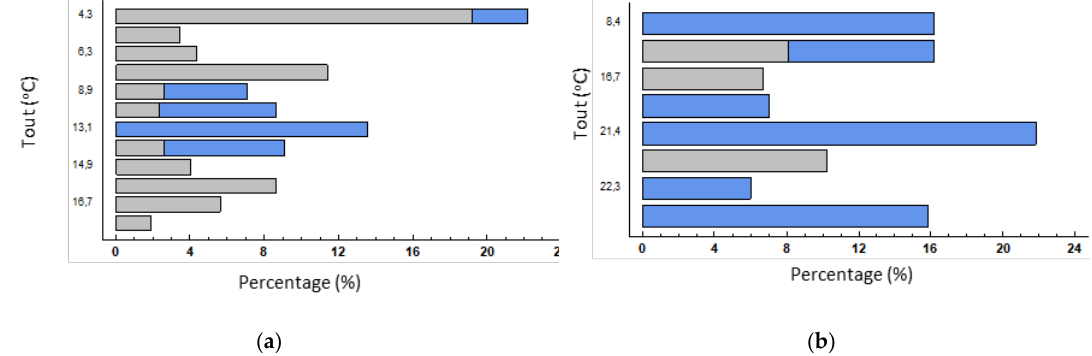
Figure 12. Cross-tabulation for windows’ opening and outdoor air temperature. ( a ) Cross-tabulation for windows opening and outdoor air temperature in winter: windows closed (gray) and open (blue). ( b ) Cross-tabulation for windows opening and outdoor air temperature in mid-season: windows closed (gray) and open (blue).